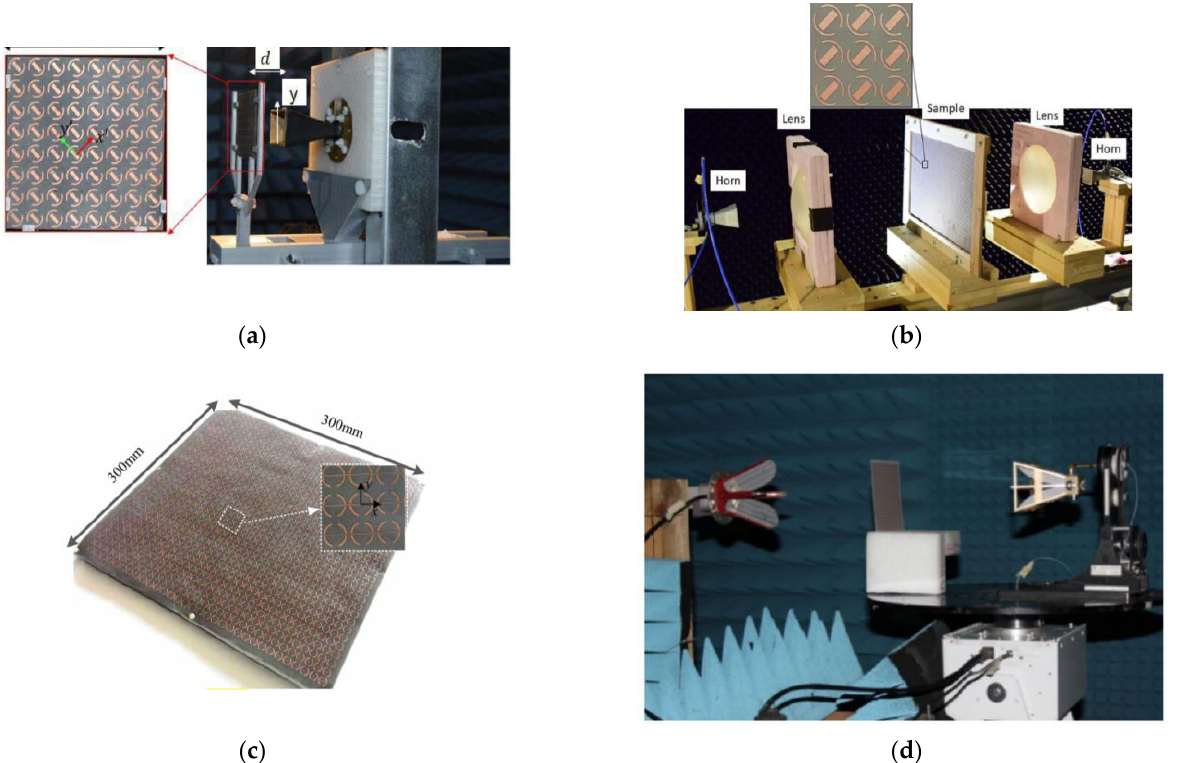
Figure 6. Multiband polarization converters; ( a ) 3D printed setup to hold the horn and polarizer (Reprinted, with permission, [88]; ( b ) quasi-optical measurement setup for dual-band converter (Reprinted, with permission, [93]; ( c ) sample sheet for dual-band LP-to-converter [84]; ( d ) free-space measurement system used in [81]. Table 2. State-of-the-art transmission-based multiband MS-based LP-to-CP